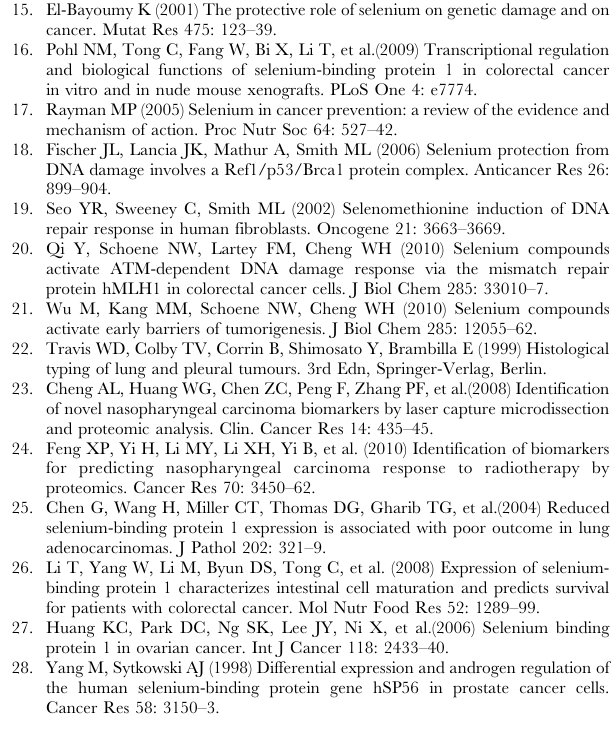
Table S2 Differentially expressed proteins during bron- chial epithelial